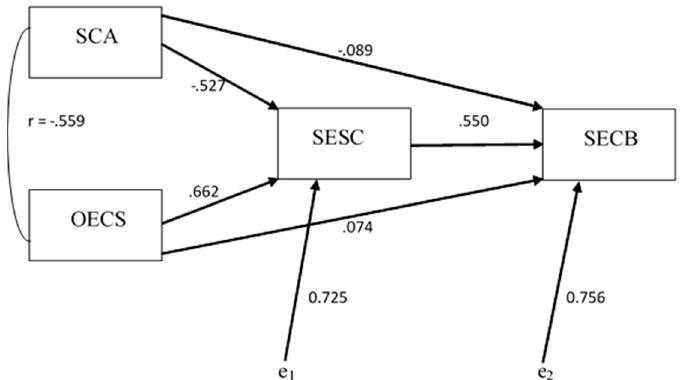
Figure 2. Mediation model of the relation between the predictors SCA, OECS and the criterion SECB by the predictor SESC.